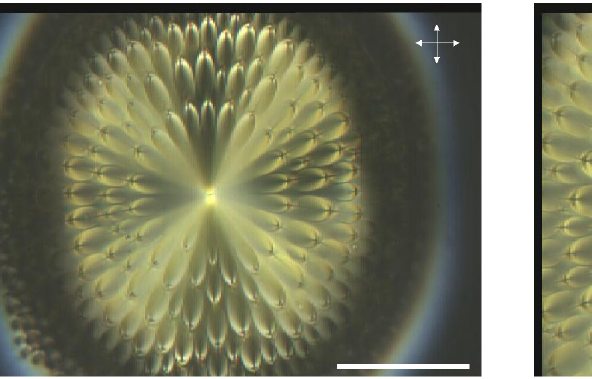
Figure 2. (a): experimental observation of the flower texture in TBDA, bar ∼ 100 µm ; (b): experimental observation of the flower texture in TBDA, bar ∼ 100 µm